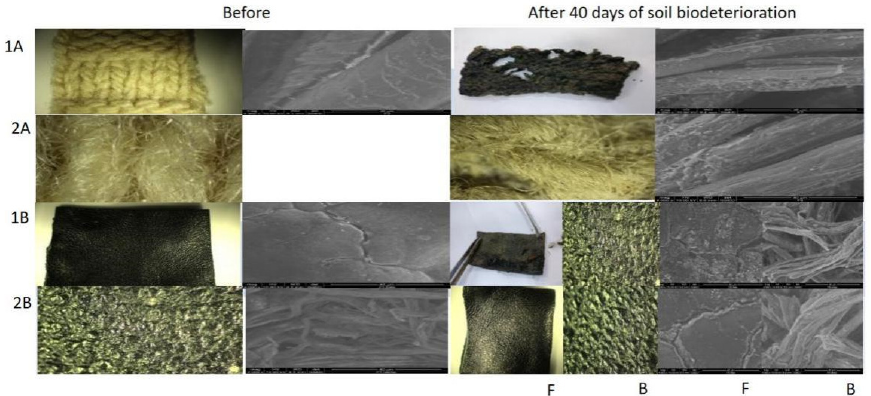
Figure 2. Biodeterioration of animal-based products (A—wool and B—leather, F—front side and B—back side) in soil #1 from Ceatalchioi and soil #2 from Bididia-Mineri. Material morphology changes were observed using stereomicroscope (right images) and scanning electron microscopy (2000×/4000×) (left images).